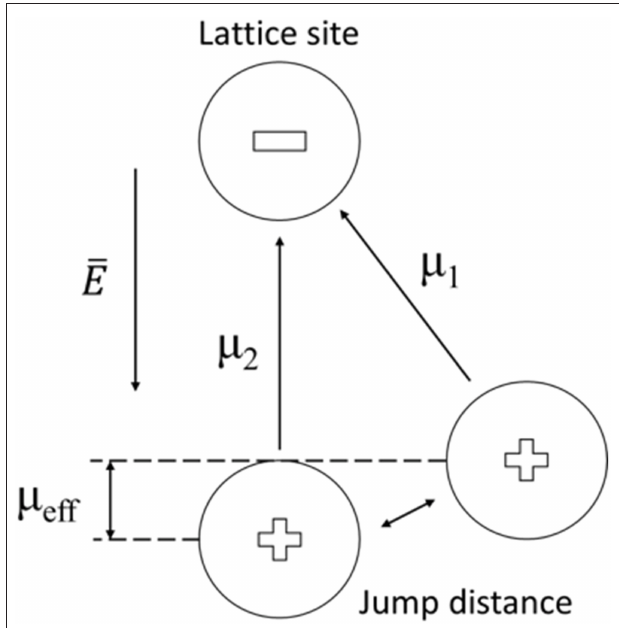
FIGURE 6 | Schematic for dipole moment between cation and lattice site by a change of place of the cation in a zeolite